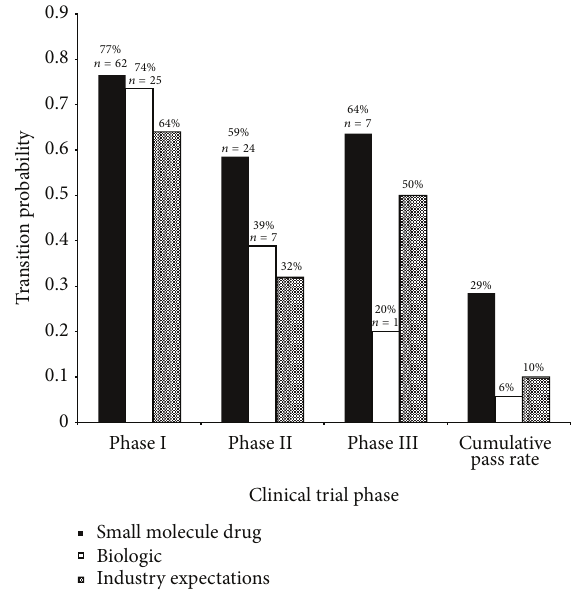
Figure5:Successratebasedondrugclass.Clinicaltrialsuccessrates in hepatitis C based on the drug class, being either a small molecule drug or a biologic. The transition probabilities for each phase as well as the cumulative pass rates were calculated. It is apparent that there are many more small molecule drugs in development and they have a much higher cumulative pass rate than